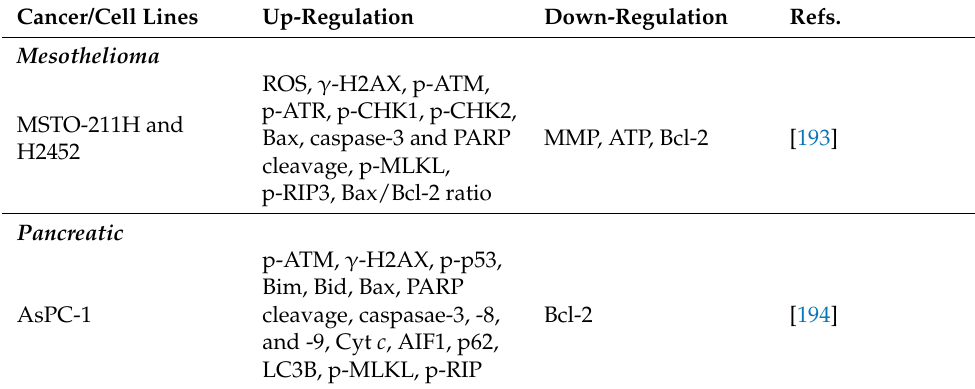
Table 3. Molecular targets of apigenin-induced necroptosis. Cancer/Cell